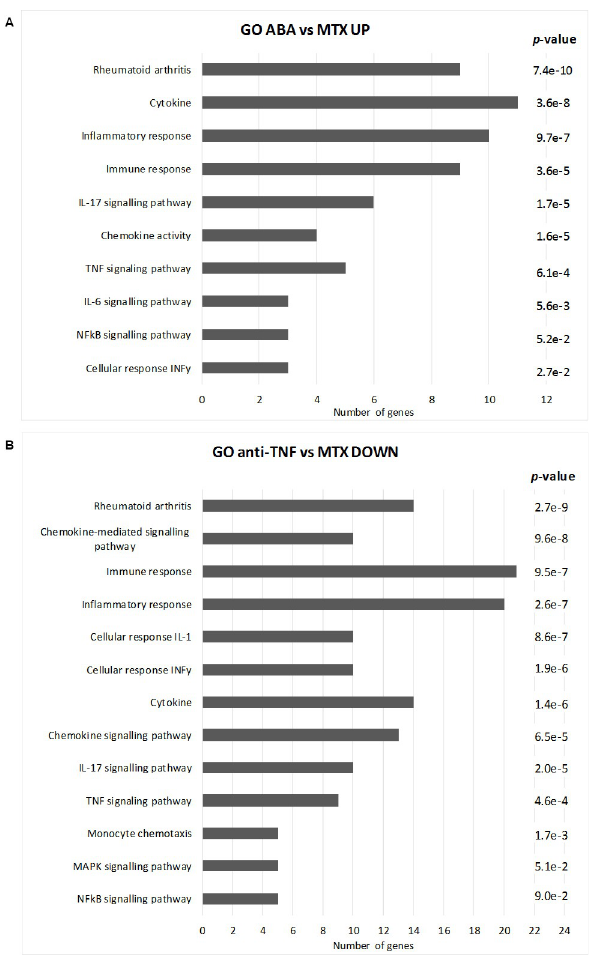
Fig 4. Functional enrichment analysis. Most significant terms, ranked by adjusted p -value, as returned by the functional enrichment analysis of the genes up-regulated by abatacept (A, ABA) and down-regulated by anti-TNF α (B) in comparison to methotrexate (MTX). Length of the bars represent the number of genes (x axis) involved in each GO term or